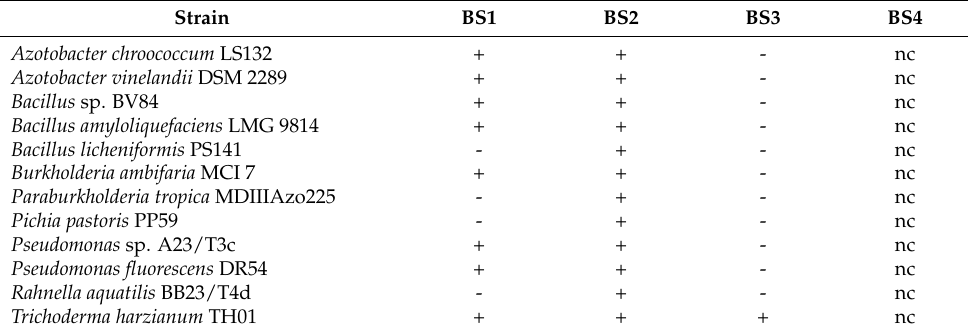
Table 5. Qualitative Effect of Bioactive Compounds on Microbial Growth.